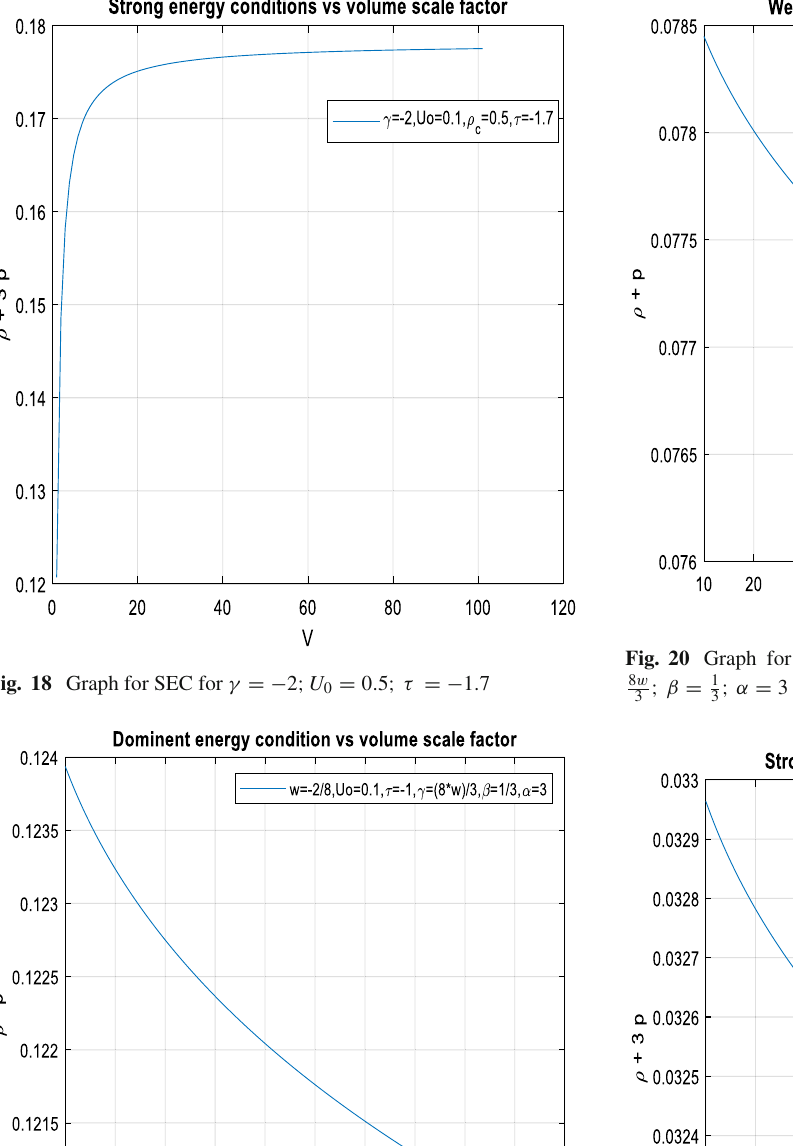
; U = 0 . 1 ; τ = − 1 ; γ = 8 w 0 8